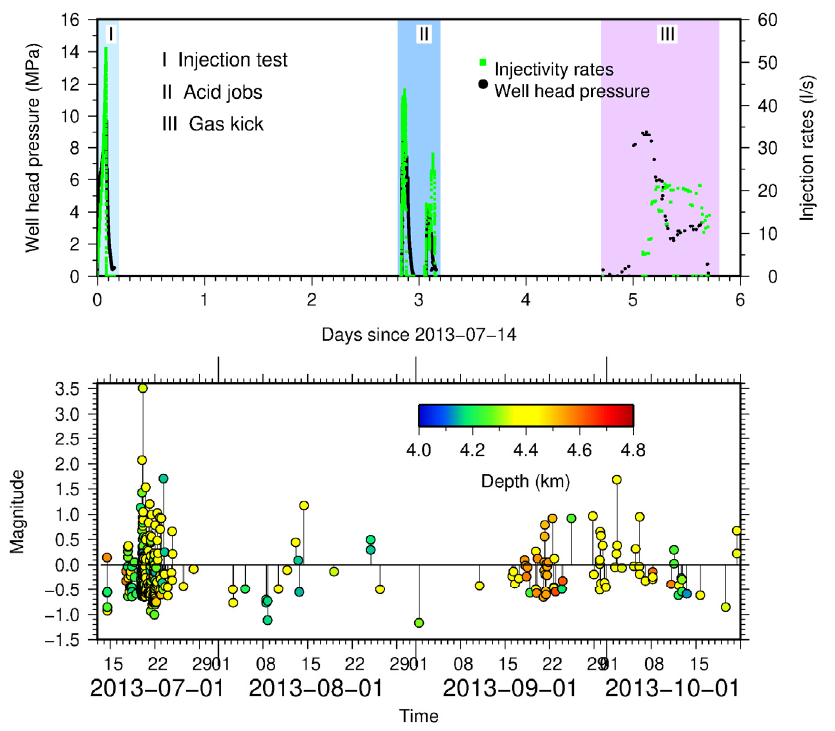
Figure 2. Upper panel: well head pressure (black dots) and injectivity rates (green dots) during the different phases of the project as reported by Moeck et al. [21]. Lower panel: temporal evolution of seismicity from 2013-07-14 to 2013-10-22. Earthquakes are color coded according to the depth .